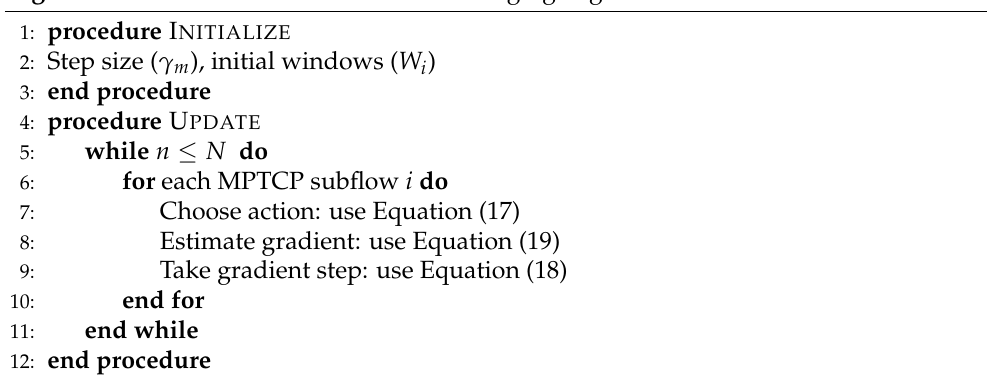
Algorithm 1 Abstract View of the Dual-Averaging